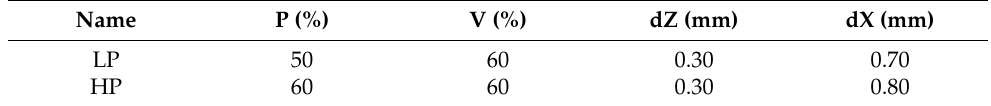
Table 1. Set of building parameters used for bulk